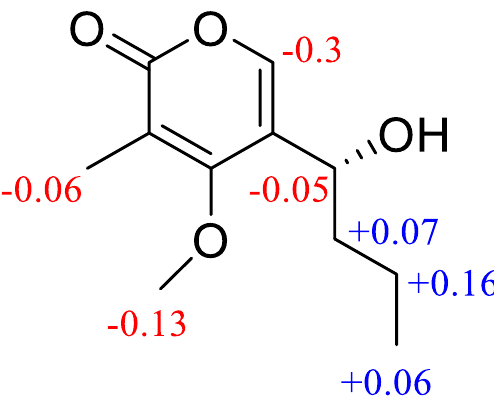
Figure 6. ∆ δ values ( δ S − δ R ) obtained for the S - and R -MTPA esters of compound 4 Figure 6. Δ δ values ( δ S − δ R ) obtained for the S - and R -MTPA esters of compound 4 .